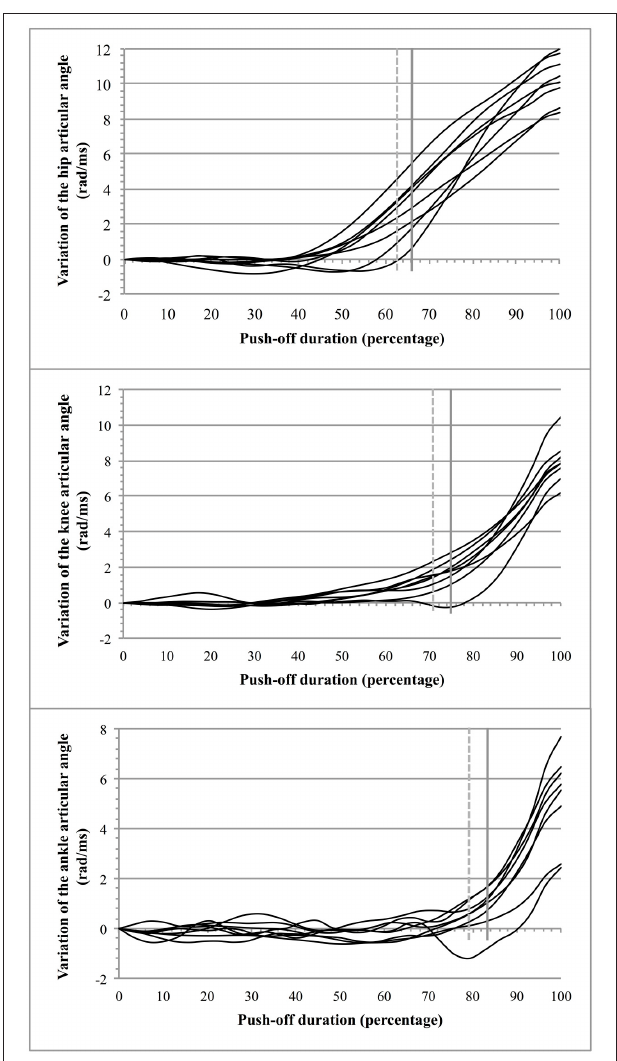
FIGURE 4 | Opening of the articular angles during push-off. For a given articular angle β i (hip, knee, and ankle): the vertical dotted gray line indicates the average breaking point obtained from the test of Buishand and the vertical full gray line indicates the average instant from which the opening of a given articular angle increases beyond the mean value of variation of the corresponding articular